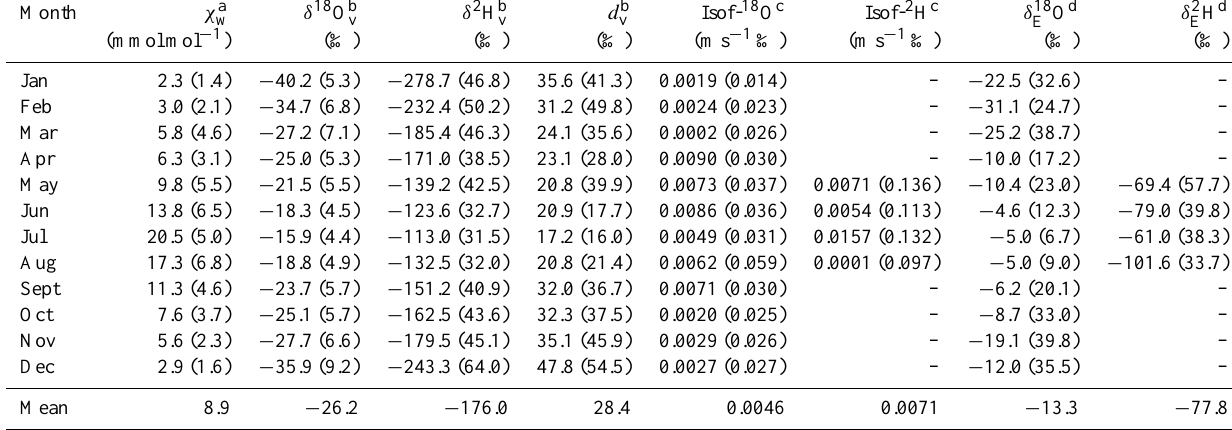
Table 1. Tall tower water vapor isotope climatology. All water vapor related data were measured at the tall tower from April 2010 to December 2012. Note that isoforcing and flux ratio values for deuterium are not reported for the non-growing season due to very low signal-to-noise ratios. All values in parentheses represent 1 standard deviation of the hourly values for the specified